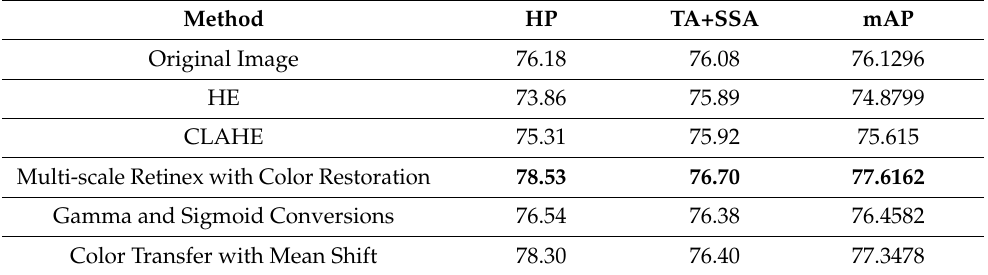
Table 2. mAP results of 3 color transfer methods in HP vs. combination of TA and